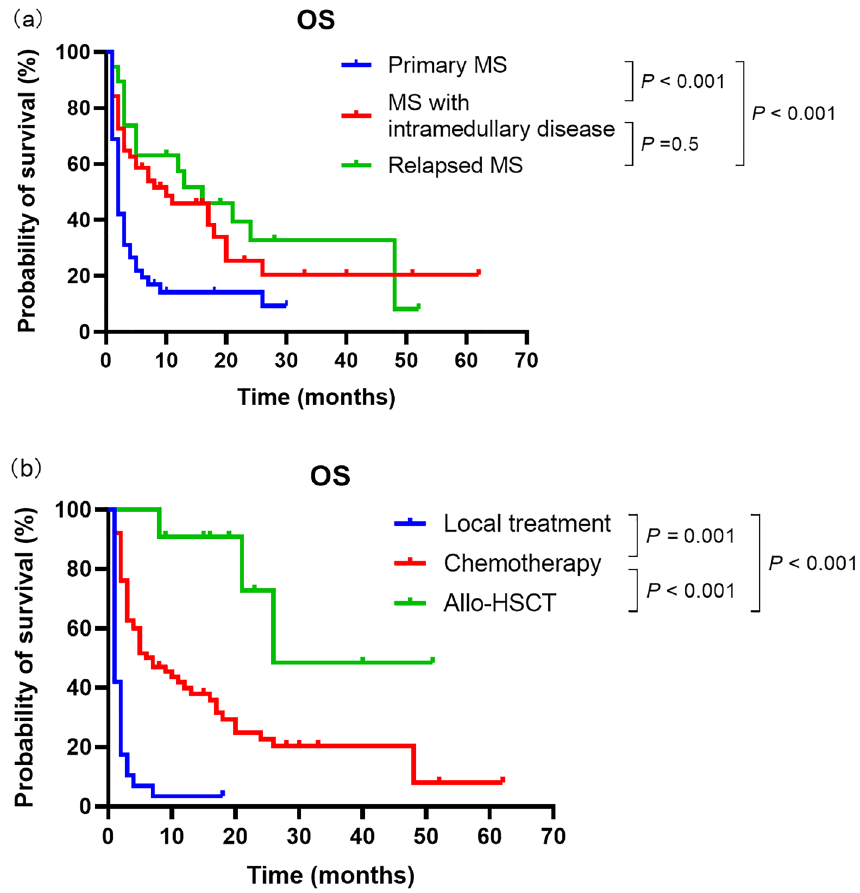
Figure 2. ( a ) Overall survival (OS) according to the myeloid sarcoma subtype: primary myeloid sarcoma (MS, n = 48), myeloid sarcoma with intramedullary disease (n = 51) and relapsed myeloid sarcoma (n = 19). ( b ) OS according to therapy: local treatment (n = 31), chemotherapy (n = 76), and allogenic hematopoietic stem cell transplantation (allo-HSCT, n = 11).